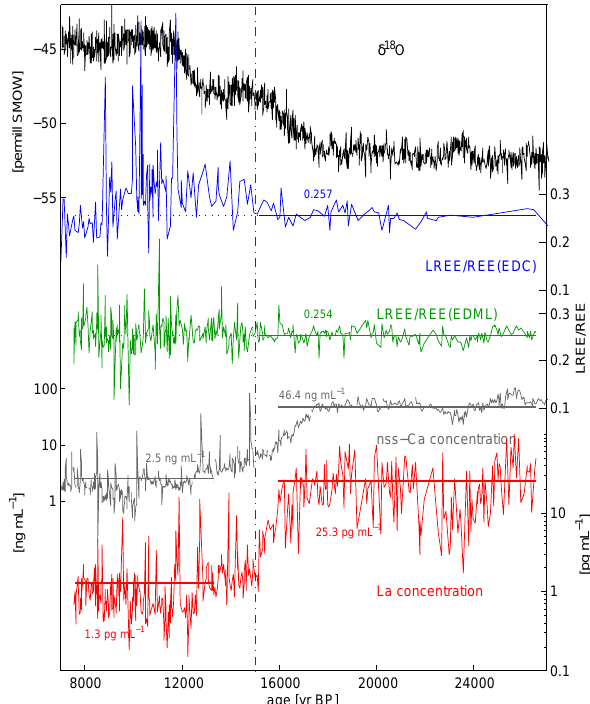
Fig. 2. Different proxies in the EDML and EDC ice cores over the LGS to Holocene transition: δ 18 O isotopic composition (top panel, EPICA, 2006); LREE/REE ratios clearly show a constant value at 0.254 during the LGS and Holocene changing to more variable ratios at 15000yrBP as indicated by the dashed vertical line. The corresponding LREE/REE profile from EDC also shows a change around 15000yrBP. nssCa 2 + concentration is a proxy for dust concentrations (after Fischer et al., 2007); La concentration is a proxy for REE